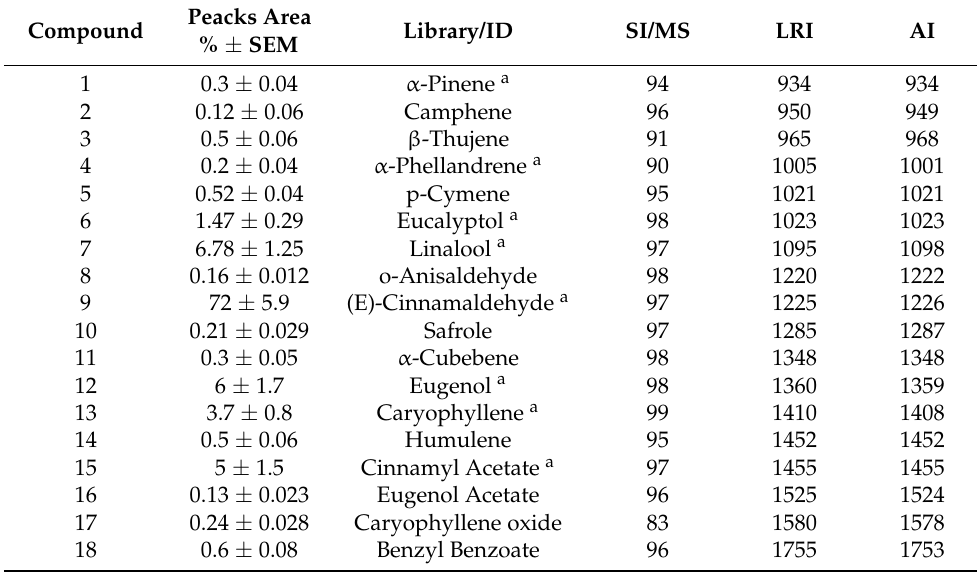
Table 1. Chemical composition of Cinnamomum verum EO.